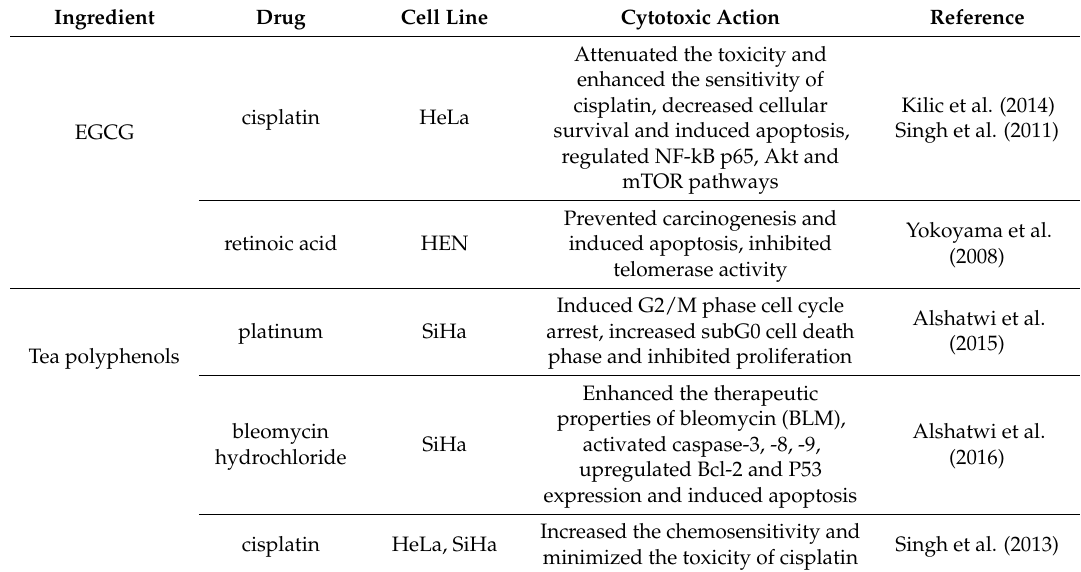
Table 1. Pharmaceutical synergistic effects of EGCG and tea